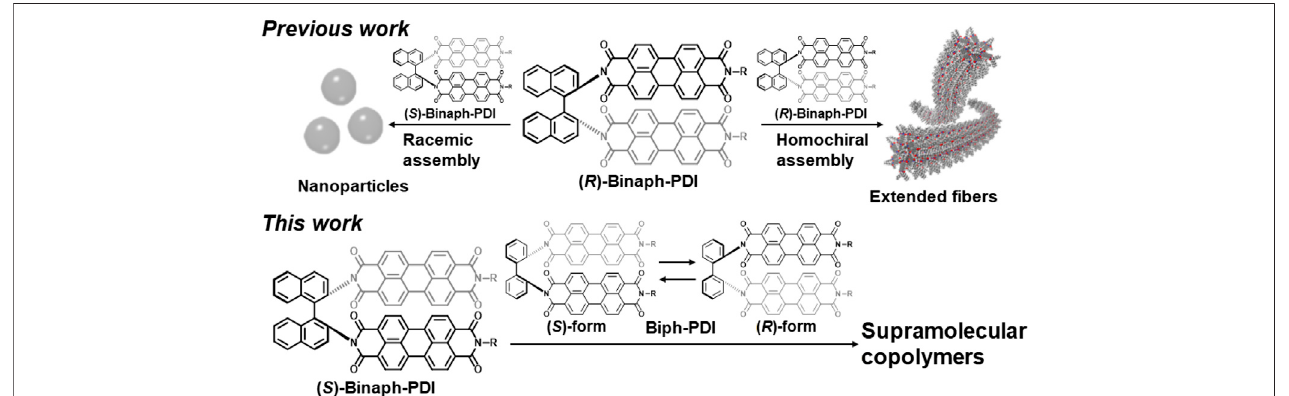
FIGURE 1 | Shape-recognition mediated self-assembly of Binaph-PDI and its coassembly with Biph-PDI [R (cid:1) CH – (C